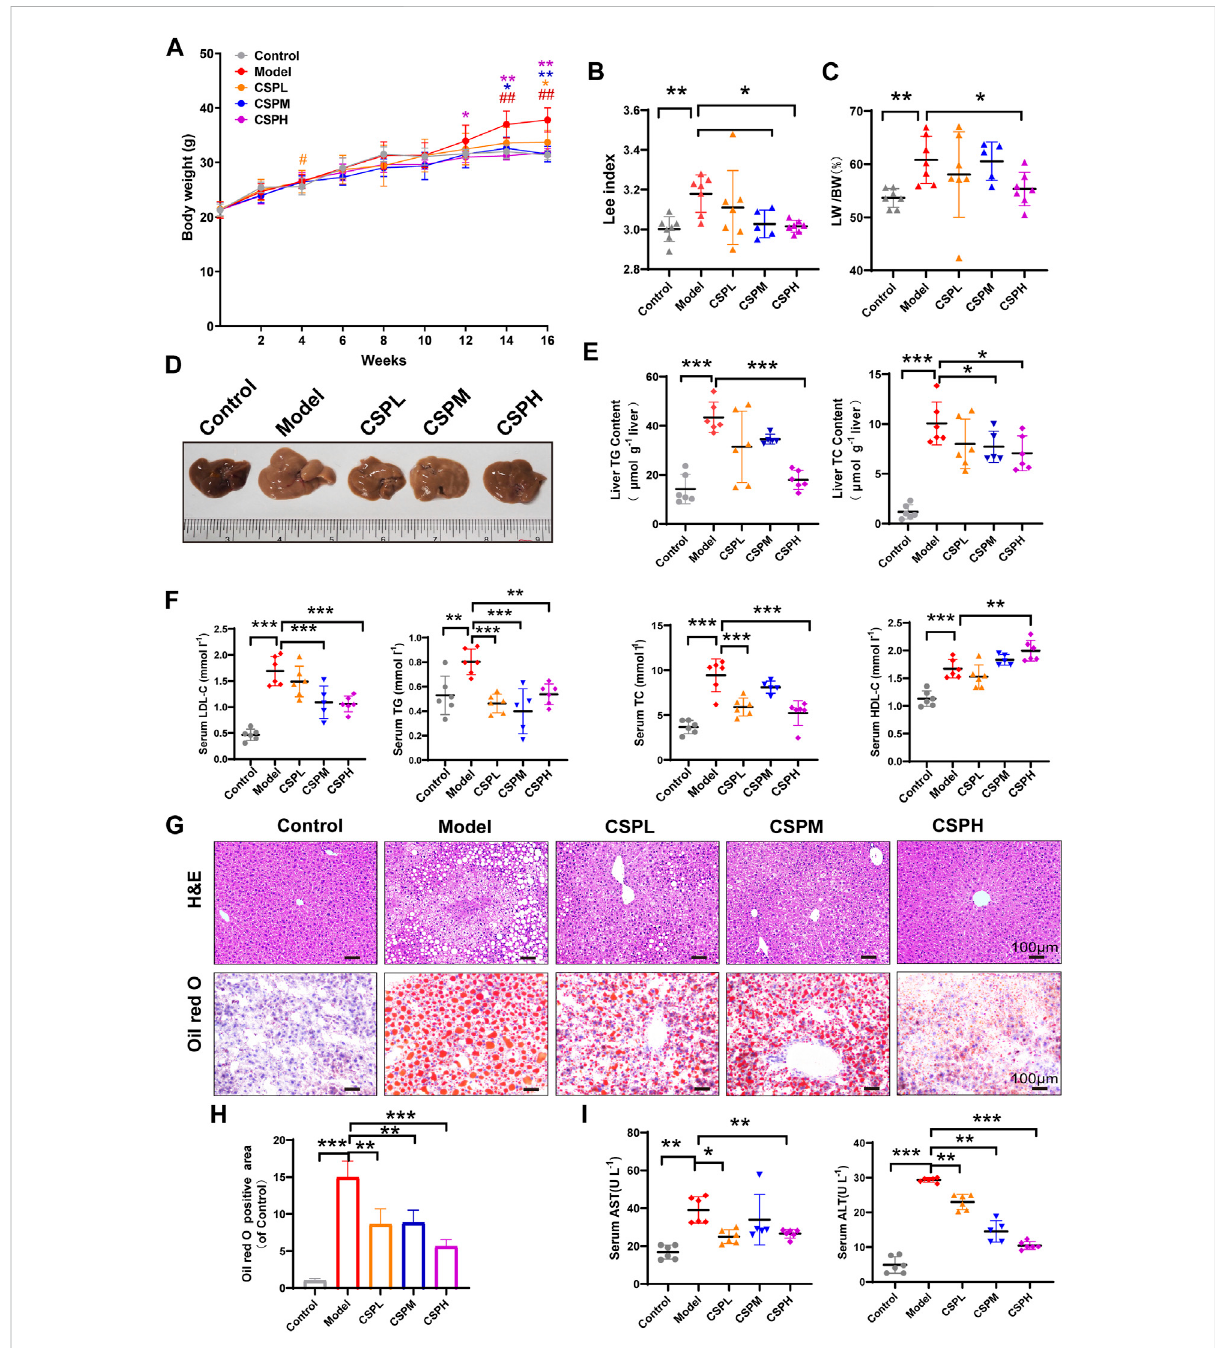
FIGURE 4 CSPamelioratedobesityandliverlipidaccumulationinmicefedaHFHFDdietandCIS. (A – C) Themousebodyweightsat0,2,4,6,8,12,14,and 16 weeks and the Lee index and liver-to-body weight ratio at 16 weeks, means ± s.d. # p < 0.05, ## p < 0.01, * p < 0.05, ** p < 0.01, # vs. the control group, * vs. the model group, n = 5-7 samples per group; (D) Representative images of mouse livers after 16 weeks of treatment. (E,F) The lipid pro fi les in the liver and serum of mice after 16 weeks of treatment; (I) Serum AST and ALT concentrations after 16 weeks of treatment; (G,H) Representative images of H&E-stained sections and Oil Red O-stained sections of the liver at 16 weeks (scale bar: 100 μ m). Data in (E – I) are presented as the means ± s.d.* p < 0.05, ** p < 0.01, *** p < 0.001, (E,F,I) n = 5-6 samples per group, (H) n = 3 samples per